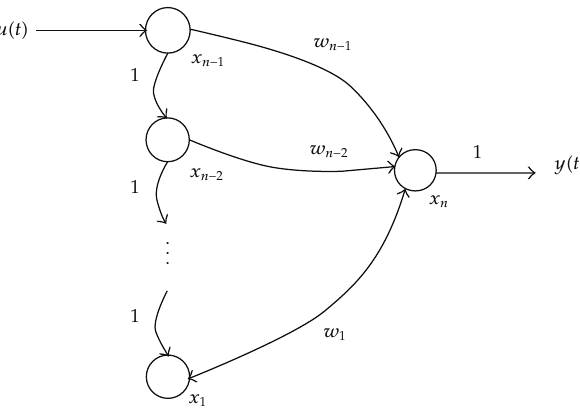
Figure 1: Class of recurrent neural